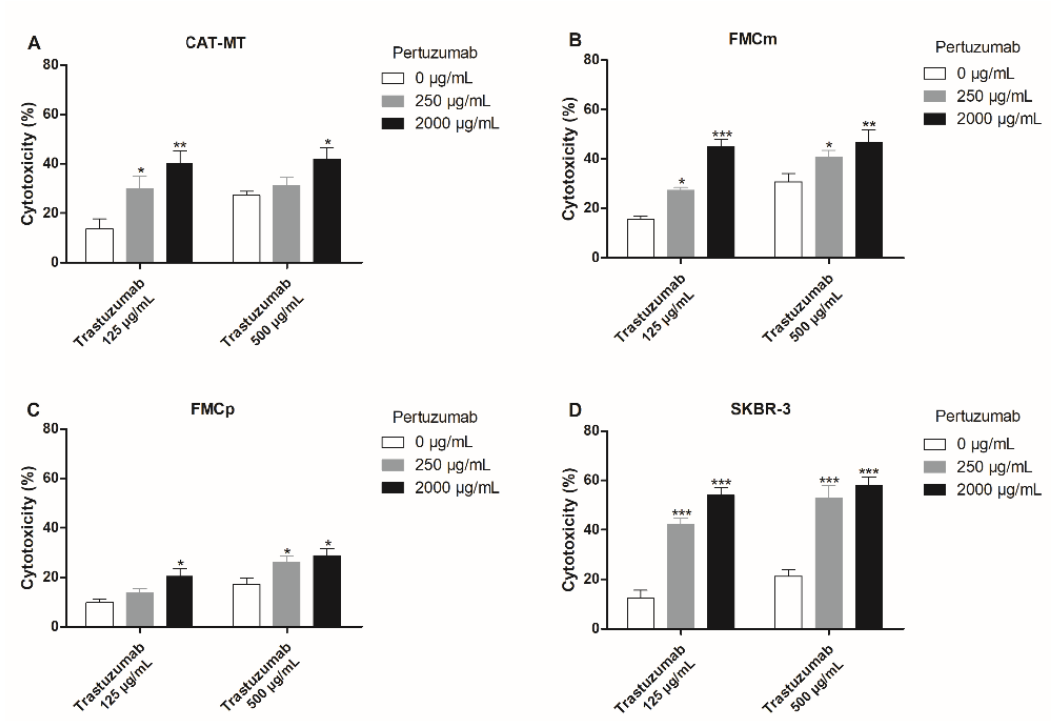
Figure 4. Combined treatments with trastuzumab plus pertuzumab showed synergistic antiproliferative effects in the carcinoma cell lines. ( A ) CAT-MT cells presented the highest cytotoxic response by the use of trastuzumab at 125 µ g/mL plus pertuzumab at 2000 µ g/mL, being possible to achieve 40.0% of cytotoxicity (** p < 0.01). ( B ) In FMCm cell line, the combination trastuzumab at 125 µ g/mL plus pertuzumab at 2000 µ g/mL was the one that allows to achieve the highest cytotoxic effect, 45.1% of cytotoxicity (*** p < 0.001). ( C ) In the FMCp cells a maximum cytotoxic effect of 28.8% using the combination trastuzumab at 500 µ g/mL plus pertuzumab at 2000 µ g/mL (* p < 0.05) was achieved. ( D ) Similarly to the feline cell lines, in the human SKBR-3 cell line synergistic antiproliferative effects were obtained, revealing all the combinations valuable. The experiments were performed in triplicates and repeated three separate times.